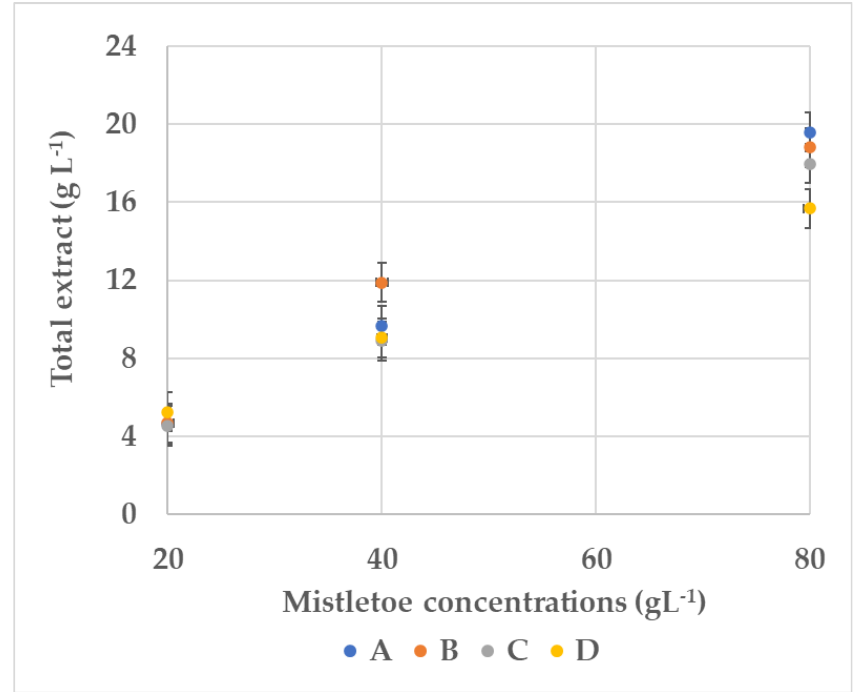
Figure 2. Total extract of mistletoe macerates prepared by maceration of 20 g/L, 40 g/L, and 80 g/L mistletoe in an ethanol – water solution (A: 25%, B: 40%, C: 55%, and D: 70% v/v ethanol) at room temperature and in darkness, after 28 days of maceration.